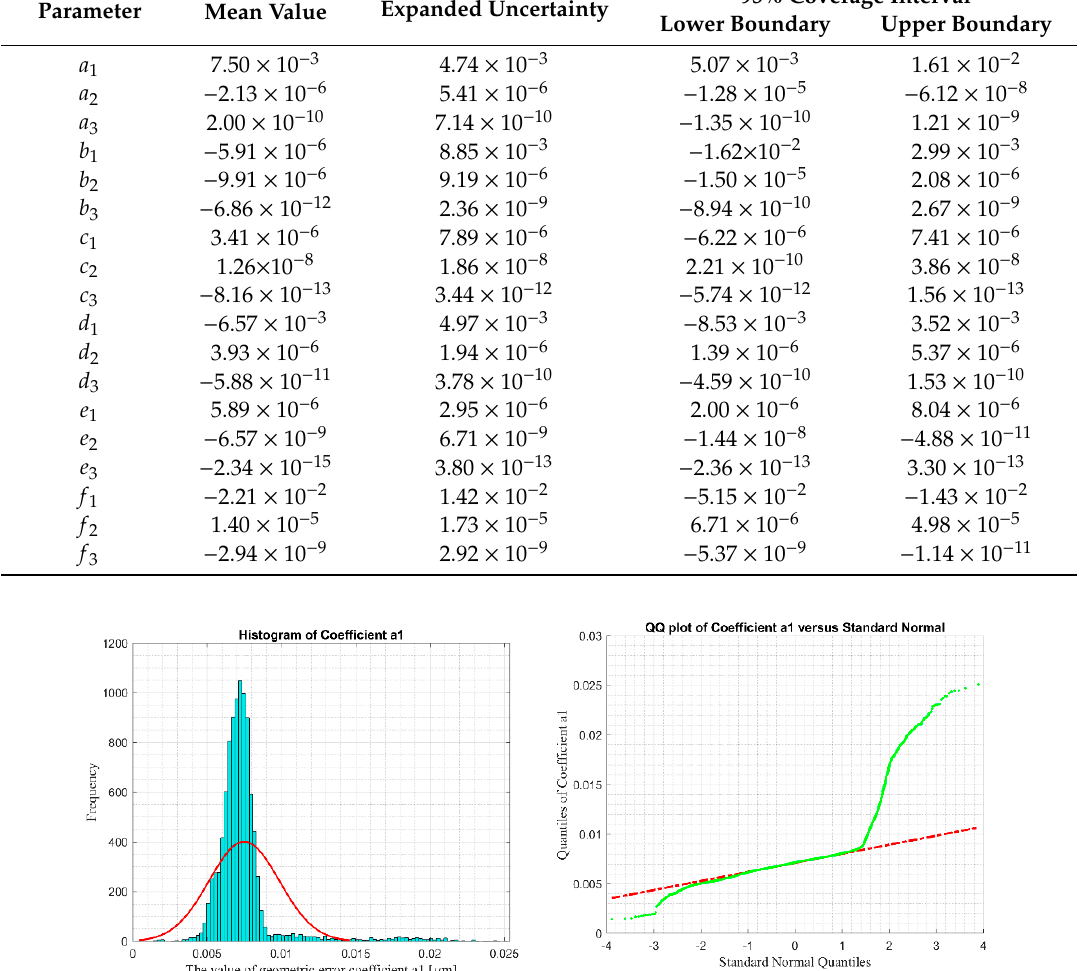
Table 3. Parameters of the coe ffi cients of the mathematical models for lateral geometric error correction.